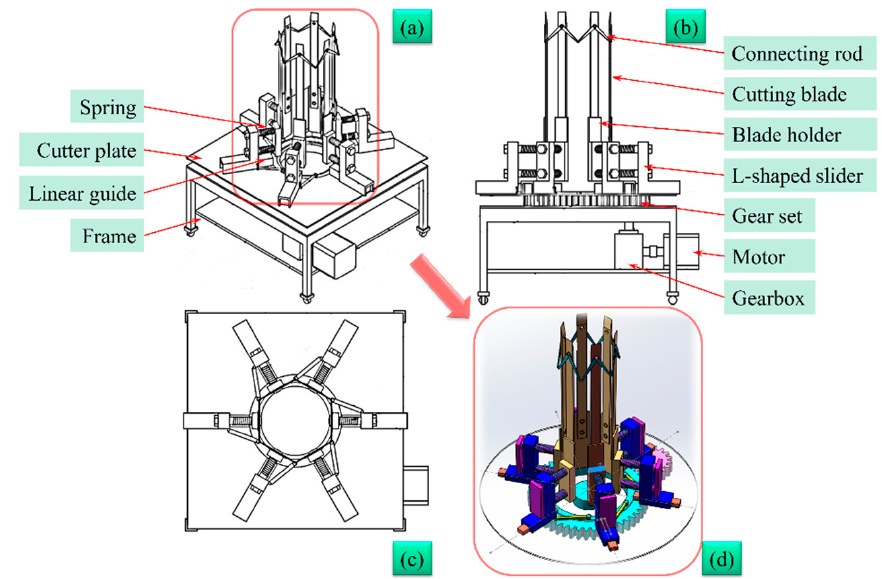
Figure 8. A de ‐ handing mechanism that can adapt to changes in the diameter of bunch stalk. ( a ) b ) Front view, ( c ) Top view, ( d ) Axonometric view of key Axonometric view, ( b ) Front view, ( c ) Top view, ( d ) Axonometric view of key components. view, (